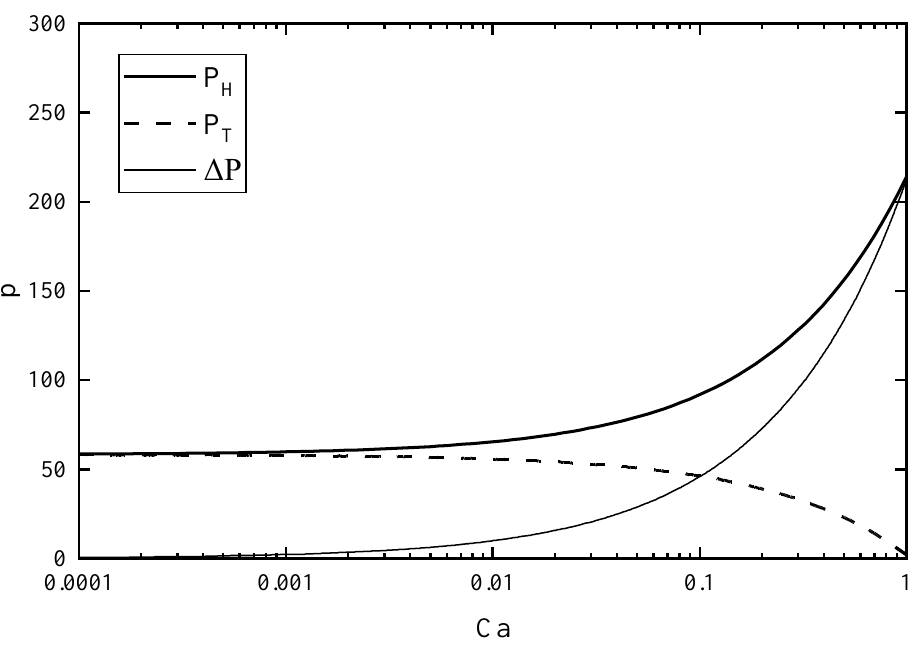
Figure 3. Analytical solution curves for the front, the tail, and the total pressure drop of the bubble. This section may be divided into subheadings. It should provide a concise and precise description of the experimental results, their interpretation, as well as the experimental conclusions that can be drawn.